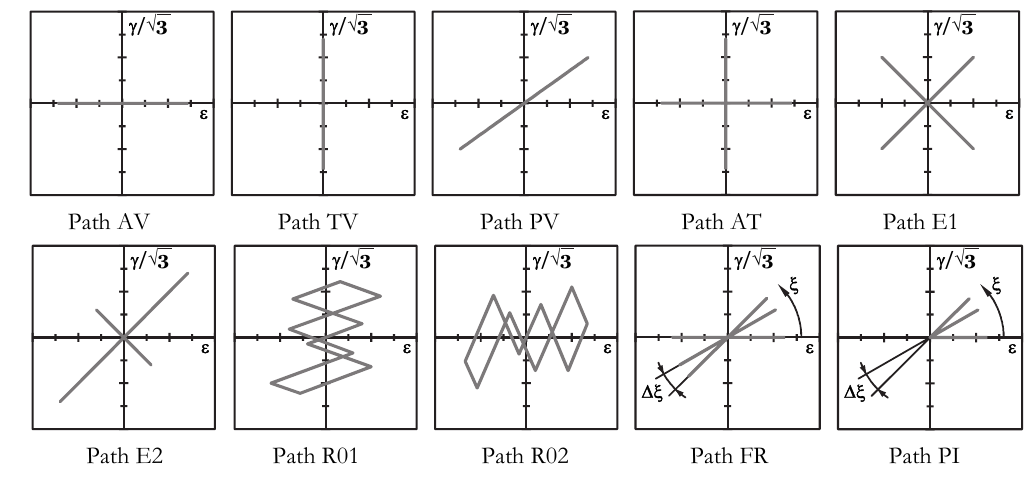
Figure 2: Investigated loading paths